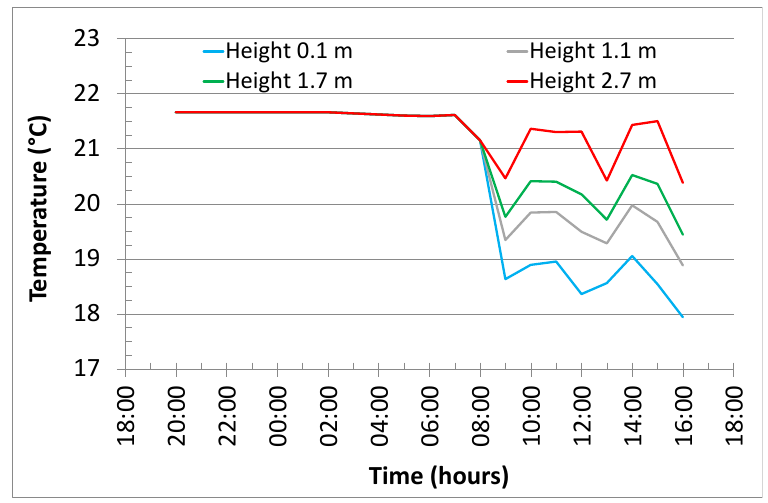
Figure 20. Detailed energy balance for the simulated classroom model. Figure 21 shows the simulated vertical temperature profiles at heights of 0.1, 1.1, 1.7, and 2.7 m above the floor level. As seen from the figure, the model did not simulate any temperature stratification in the heating mode between 20:00–8:00. In the normal mode, the model simulated a vertical temperature gradient in the room. The air temperature was lowest at the floor level and rose linearly with height. The average and maximum vertical temperature gradient between the standing head height (1.7 m) and ankle height (0.1 m) simulated by the model was 1.5 K, and 1.8 K, respectively. The simulated gradient values were greater than the experimentally measured ones.